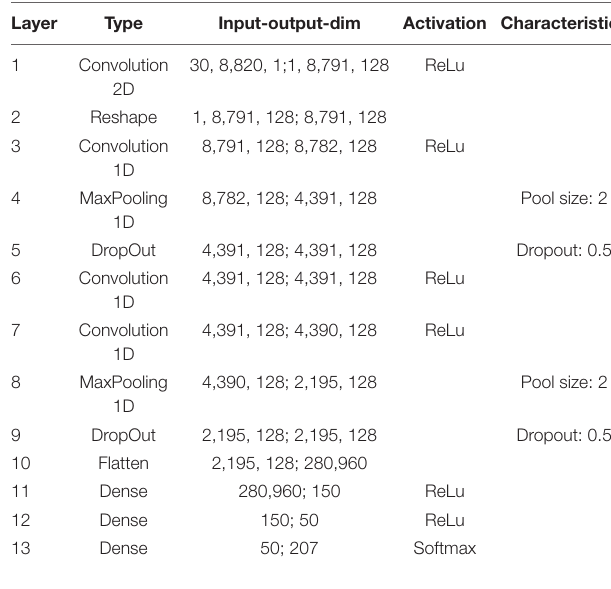
TABLE 1 | Exact parameters of the used deep convolutional network (main